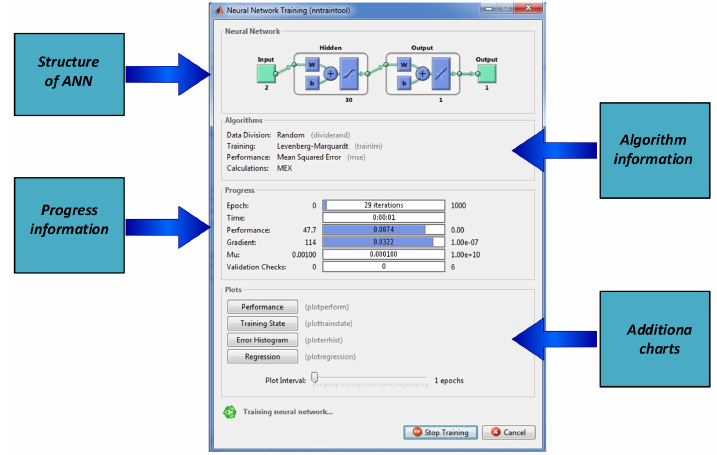
Figure 4. Matlab toolbox for ANN training and